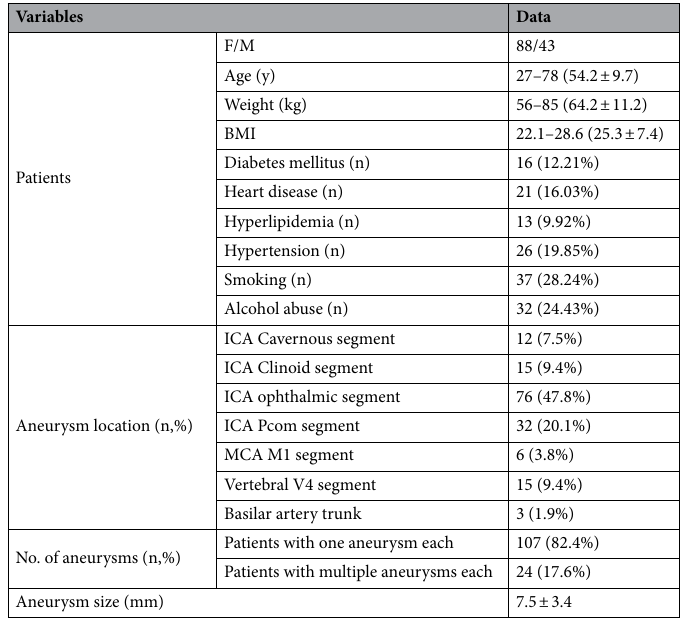
Table 1. Demography and clinical data. ICA, internal carotid artery; MCA, middle cerebral artery; Pcom, posterior communicating artery.